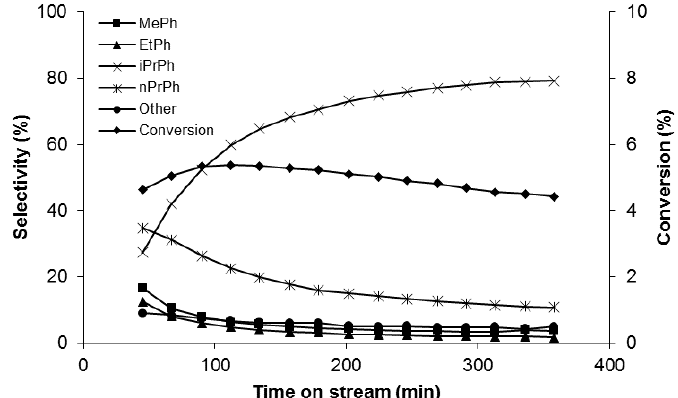
Figure 4. Time course for benzene alkylation by propane over two ‐ bed catalyst 7.1% Pd/C (0.04 g, top bed) + 25%HSiW/SiO 2 (0.16 g, bottom bed) (0.20 g total catalyst weight, 1.4% Pd, 300 °C, 1 bar pressure, inlet molar ratio C 6 H 6 /C 3 H 8 = 1:9, 10 mL min − 1 flow rate, W / F = 80 g h mol − 1 ; catalyst pre ‐ treatment at 300 °C/1 h in H 2 flow).